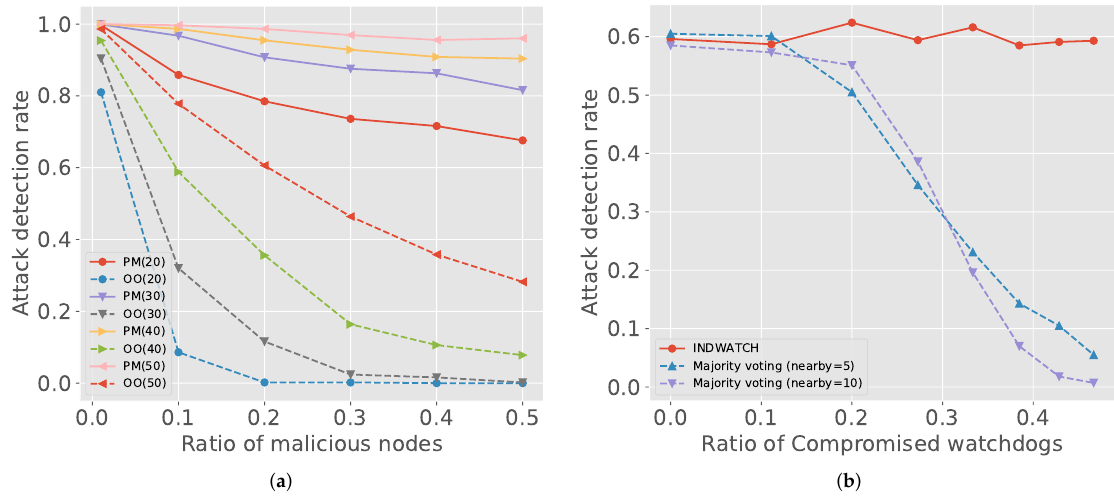
Figure 3. Comparisons of attack detection rates. ( a ) Attack detection rate with different watchdog setting. PM and OO indicate packet modification and out-of-order delivery, respectively. The number in parenthesis is the number of watchdogs. ( b ) Comparison to other distributed watchdogs approaches.